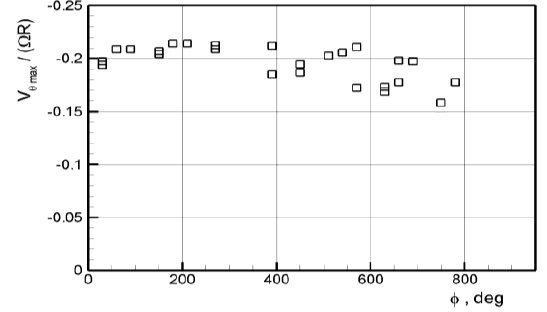
Fig.10 Peak tangential velocity as a function of vortex